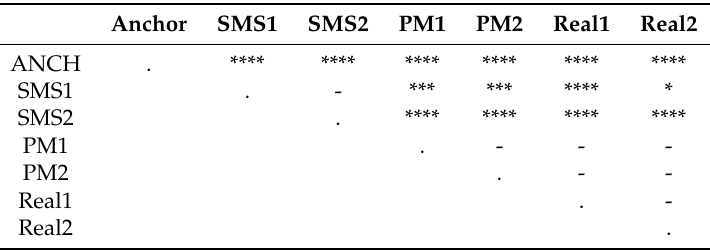
Table 6. The effect of different samples for a golf club (**** ⇒ p < 0.0001, *** ⇒ p < 0.001, ** ⇒ p < 0.01, * ⇒ p < 0.05, - ⇒ p ≥ 0.05). SMS, spectral modelling synthesis; PM, physical model; Real, recorded sample.